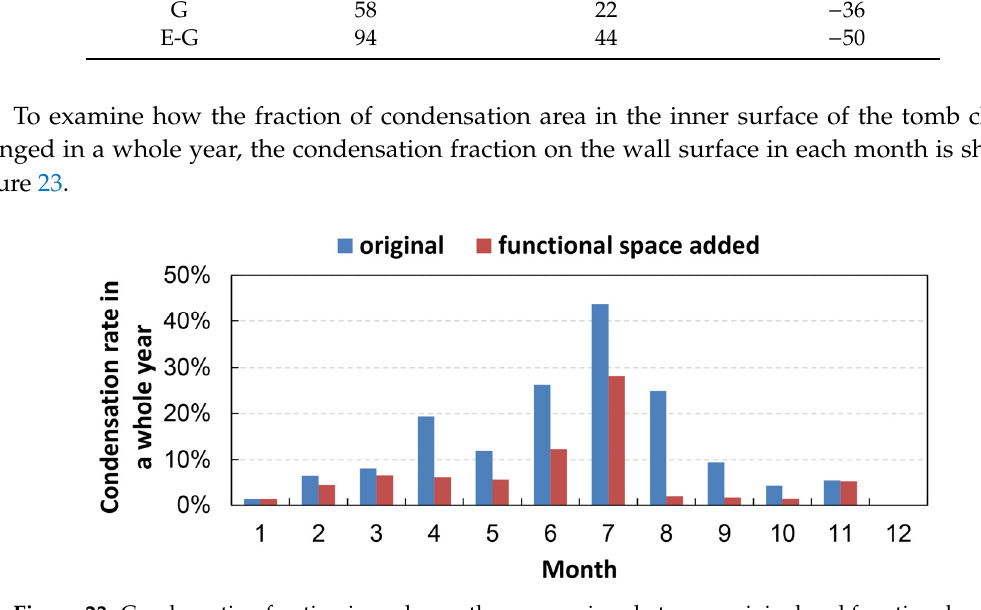
Figure 23. Condensation fraction in each month—comparison between original and functional space added cases.